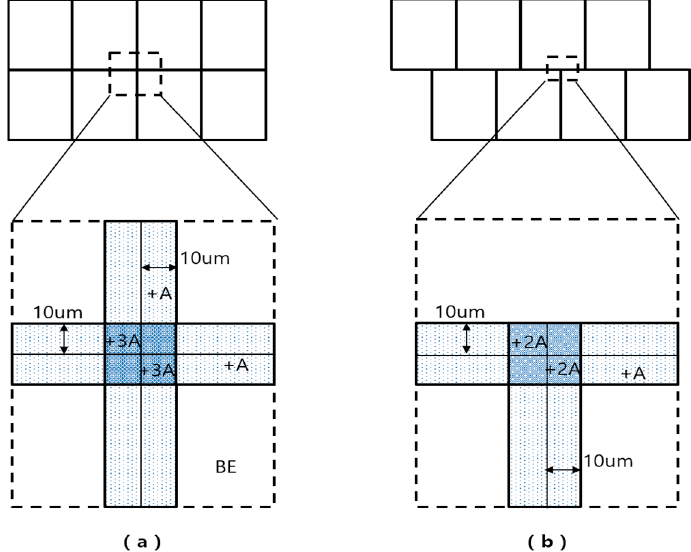
Figure 3. LFE according to the shot field arrangement. Array in which ( a ) the row is not shifted and ( b ) is shifted by 20 μ m or more.